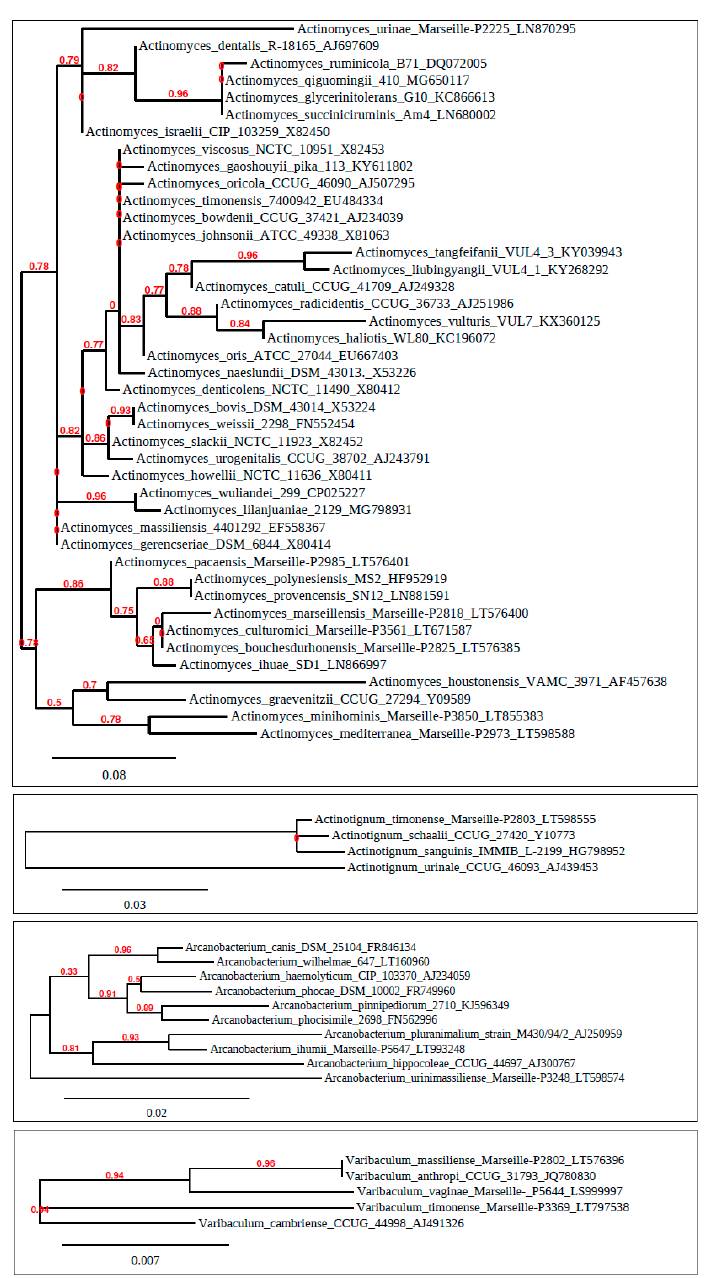
Figure 1. Phylogenetic analysis of bacterial genera discussed in this paper (namely Actinomyces , Actinotignum , Arcanobacterium, and Varibaculum ) including both pathogenic and non-pathogenic strains. Bacterial 16S rRNA gene sequences were retrieved from the LPSN (List of Prokaryotic Names with Standing in Nomenclature) database [39], while analysing phylogenetic relationships were analysed using Phylogeny.fr in a PhyML and BLAST-EXPLORER environment [40,41].